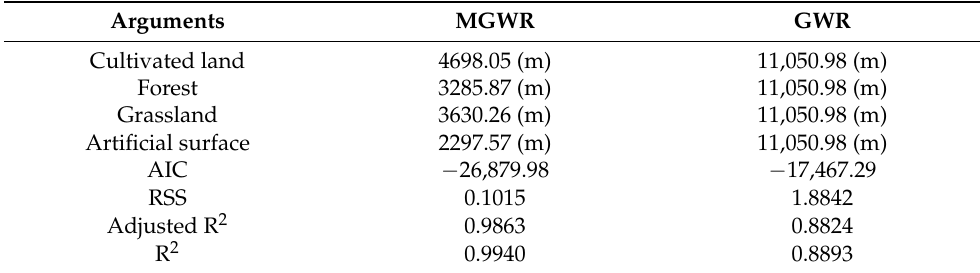
Table 2. Bandwidth and diagnostics for MGWR and